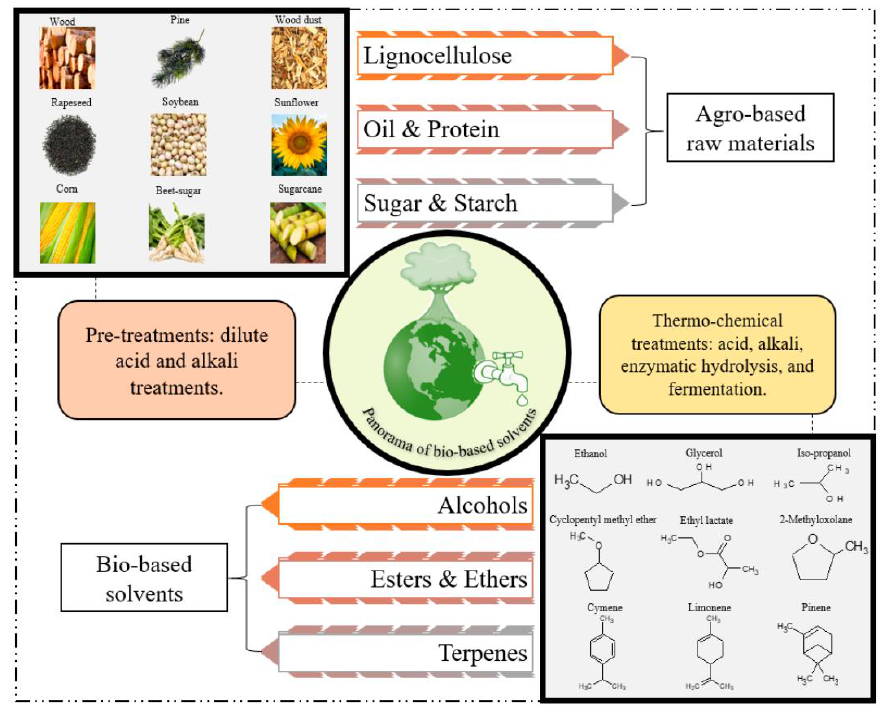
Figure 8. Bio-based solvents scenario